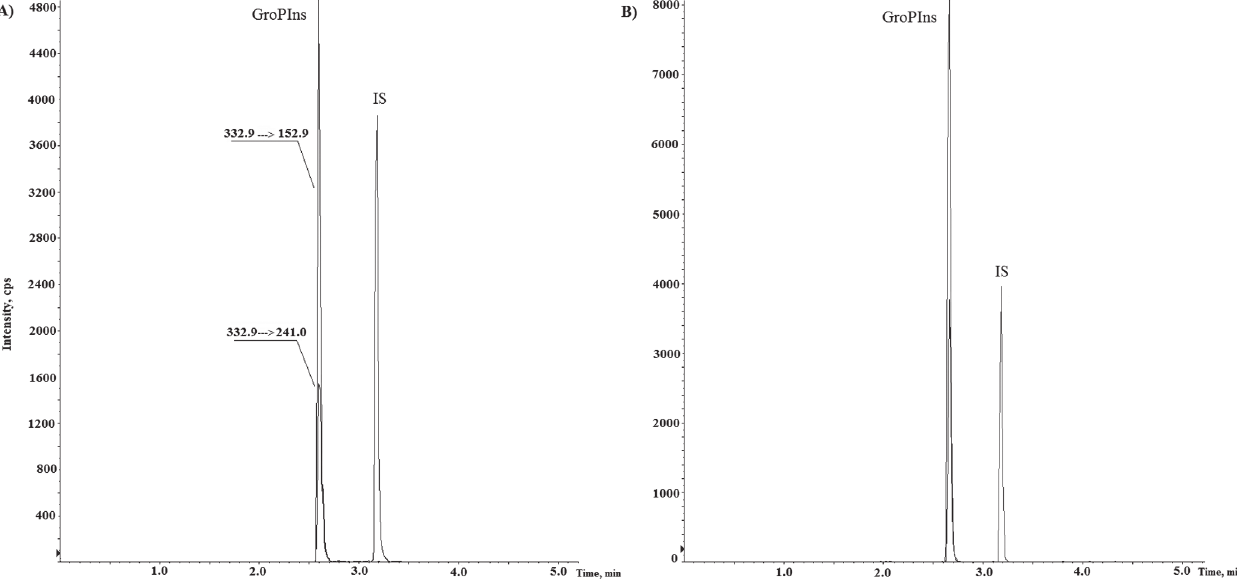
Fig 3. Representative LC-MRM chromatogram of Gro P Ins and of the IS. (A) Cell extract of Raw264.7. (B) Cell extract of Raw 264.7 spiked with standard Gro P Ins.